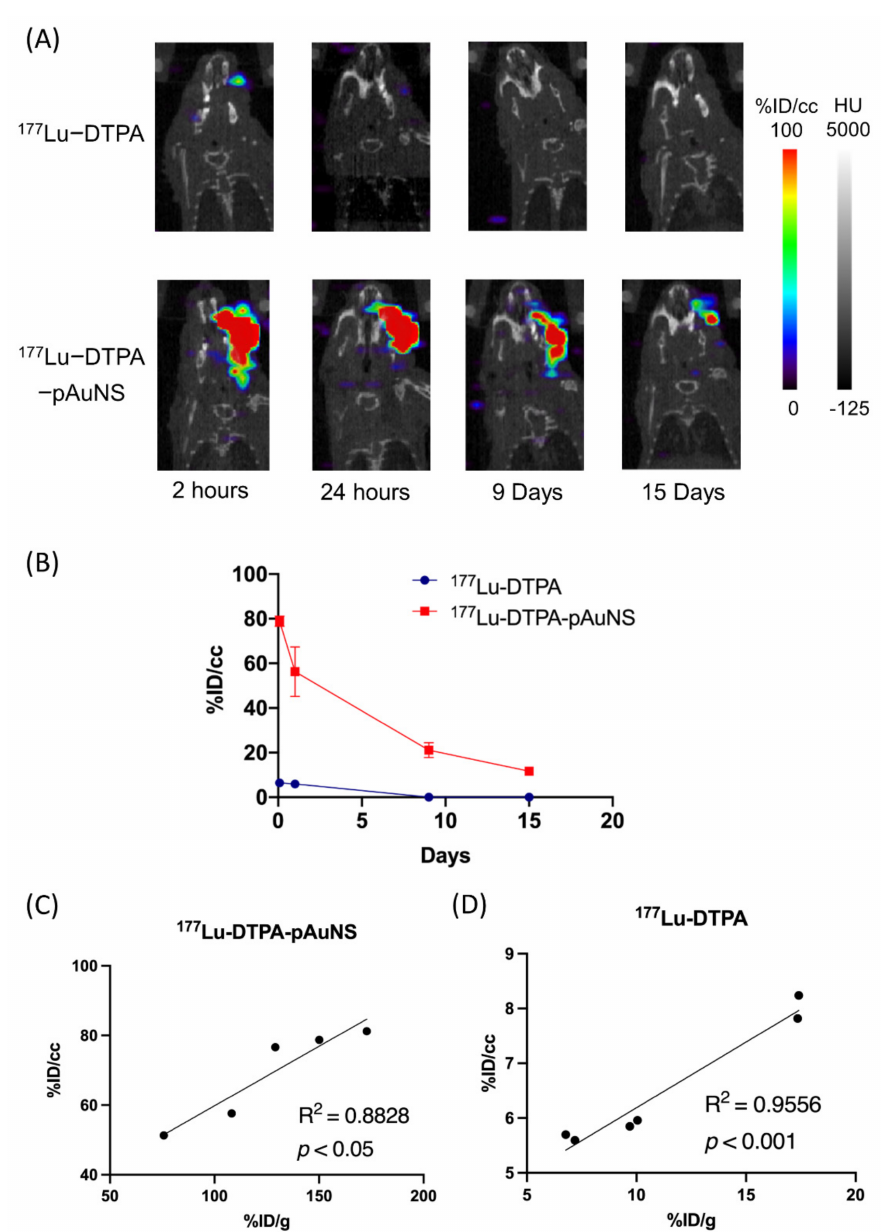
Figure 3. The evaluation of microSPECT/CT in HNSCC orthotopic tumor after intratumoral injection. ( A ) microSPECT/CT imaging of 177 Lu-DTPA and 177 Lu-DTPA-pAuNS accumulations in orthotopic HNSCC tumor-bearing mice. ( B ) The time activity curve shows the activity of the tumor area circled by the ROI (n = 3). ( C , D ) The correlation of biodistribution analysis (%ID/g) and semi-quantitative analysis (%ID/cc) in 177 Lu-DTPA-pAuNS and 177